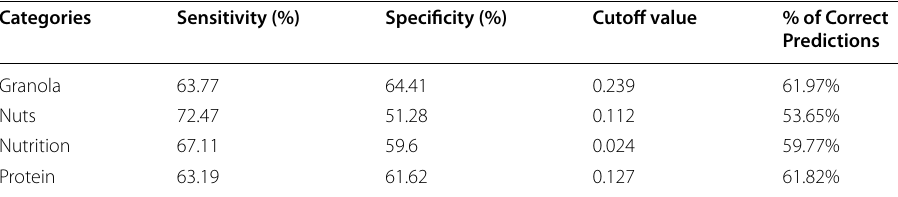
Table 5 The goodness of fit measures from the Probit model